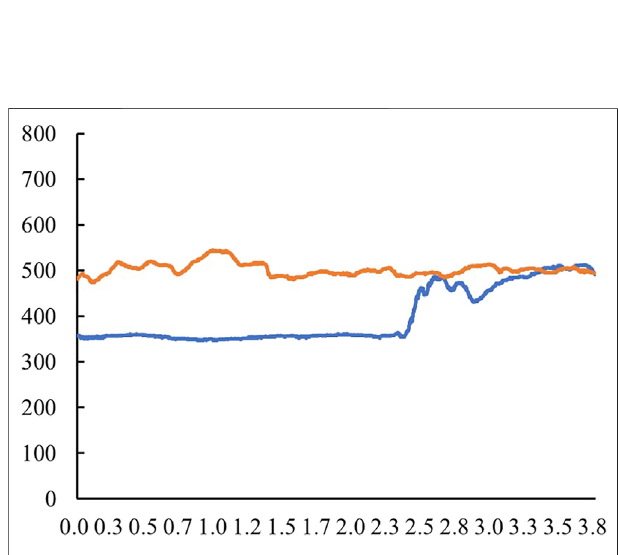
FIGURE 9 | Pushing force for the middle fi nger in cases where the EMS current value changed (case 1) and where the EMS current value did not change (case 2). We manually increased the EMS current by reading the estimated value if the estimated value was lower than 480